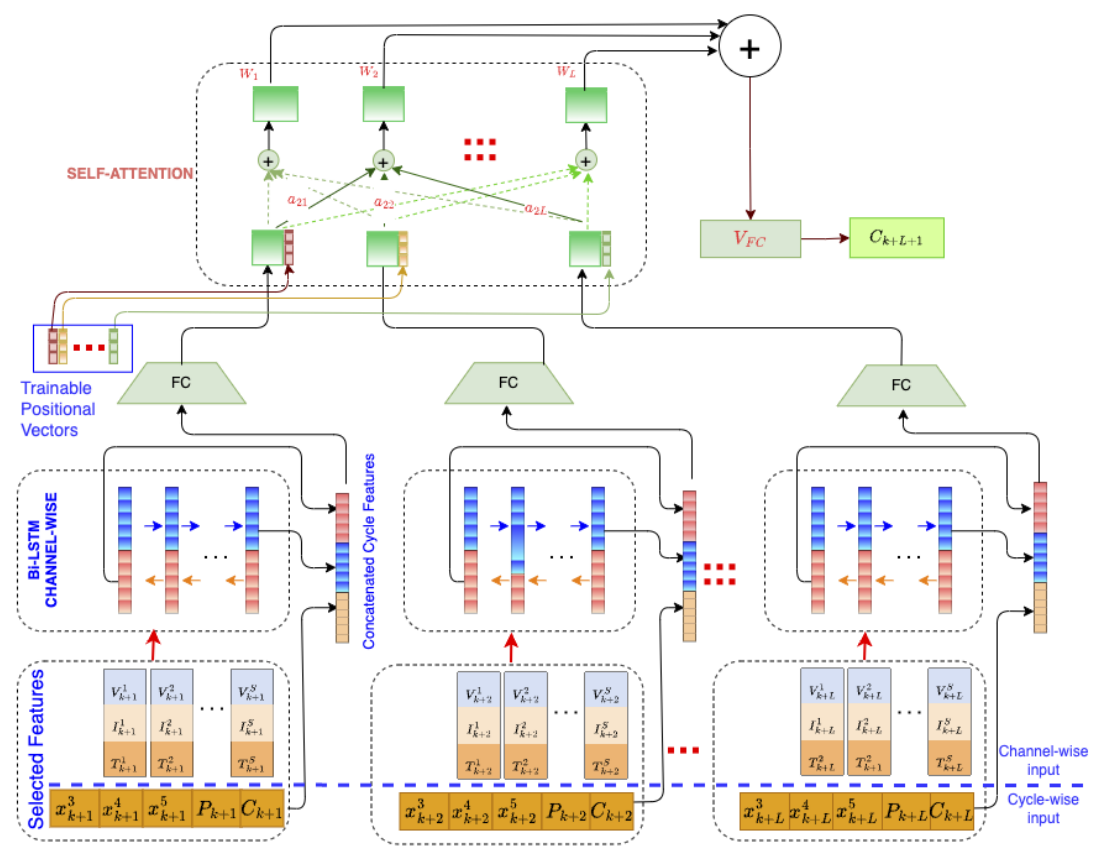
Figure 10. The Bidirectional Fixed-point Positional Encoding (BFPE) architect in SoH